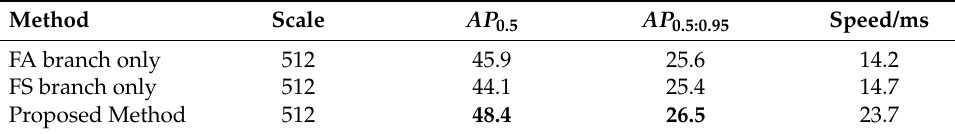
Table 8. The ablation study of the DAB structure.The best results are in